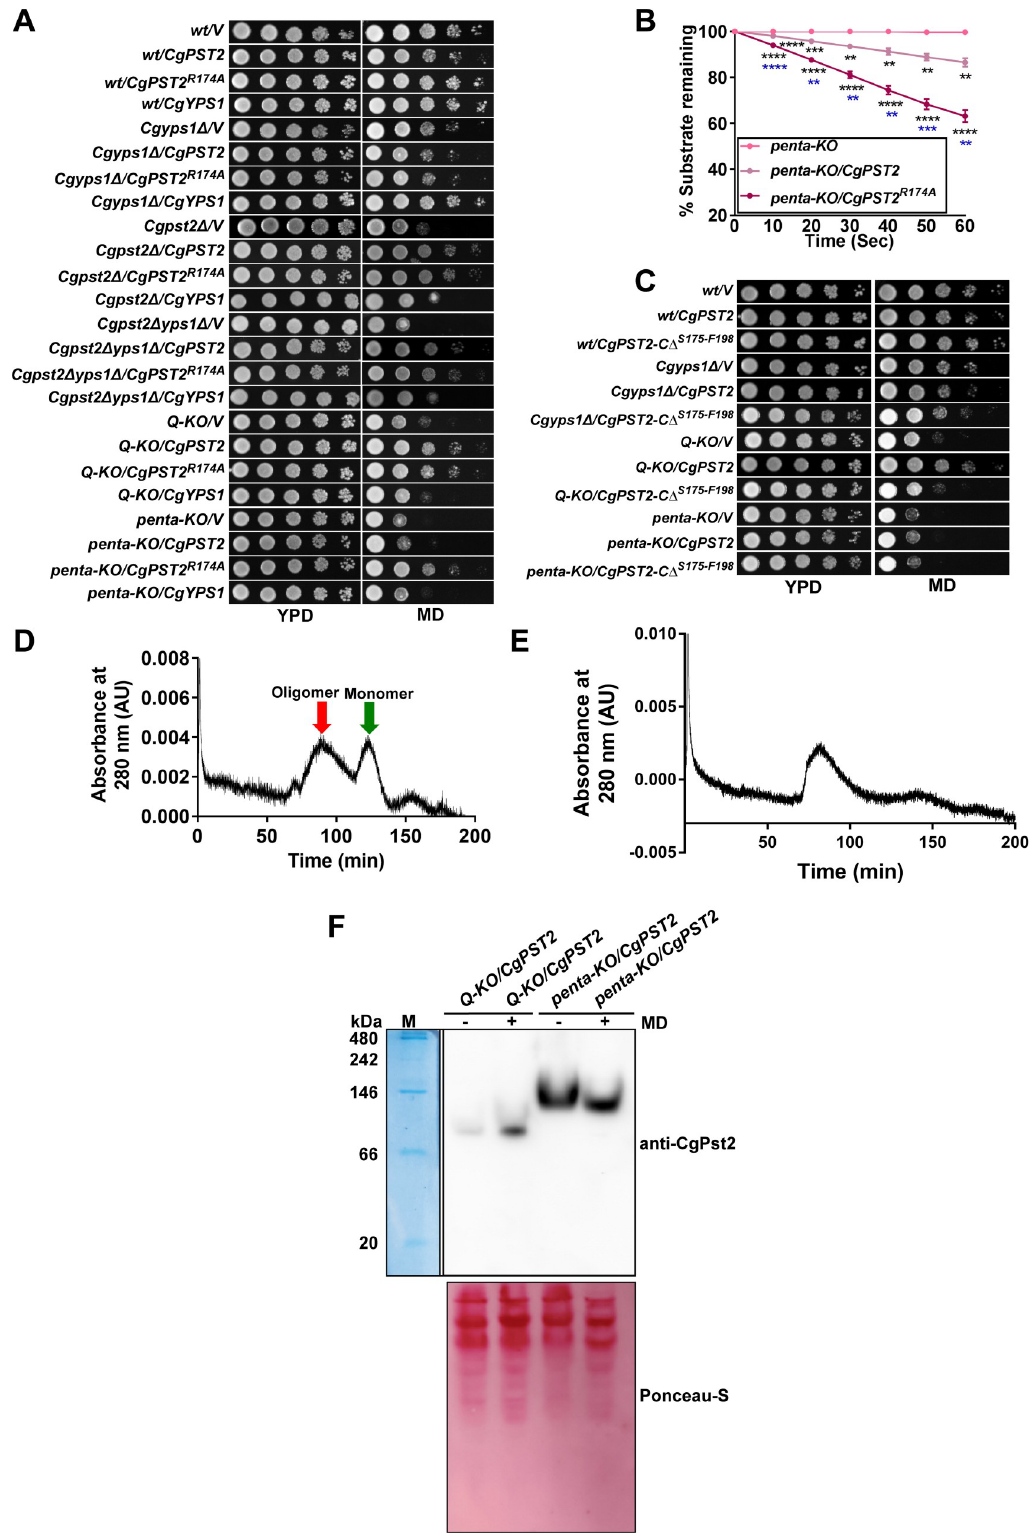
Fig 6. CgPst2 R174A rescues MD sensitivity of CgPST2 -deleted strains. A. Serial dilution spotting assay showing CgPST2 R174A - mediated rescue of MD (80 μ M) sensitivity. V, pRK74 vector. The Q-KO strain lacks four flavodoxin-like proteins